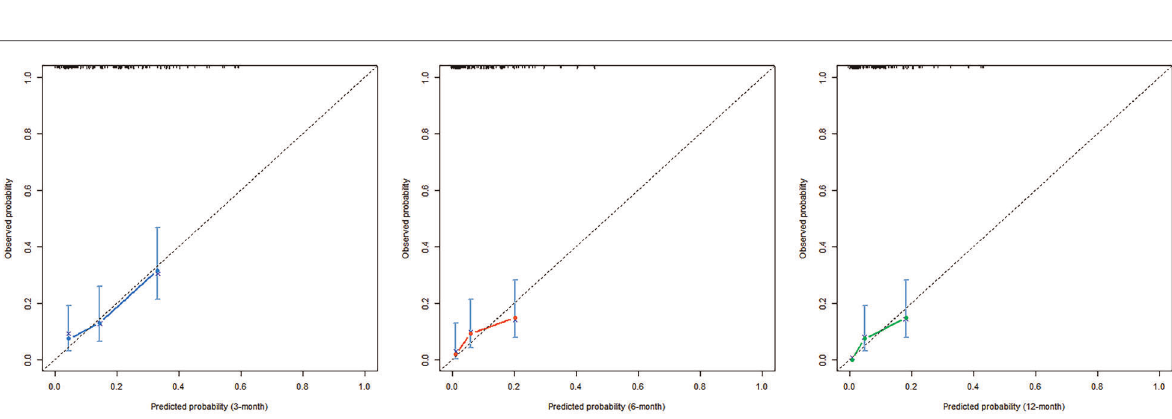
FIGURE 6 Receiver operating characteristic (ROC) curve for the prediction model. The 3-month, 6-month, and 12-month areas under the curve (AUC) were 0.741, 0.736, and 0.781.